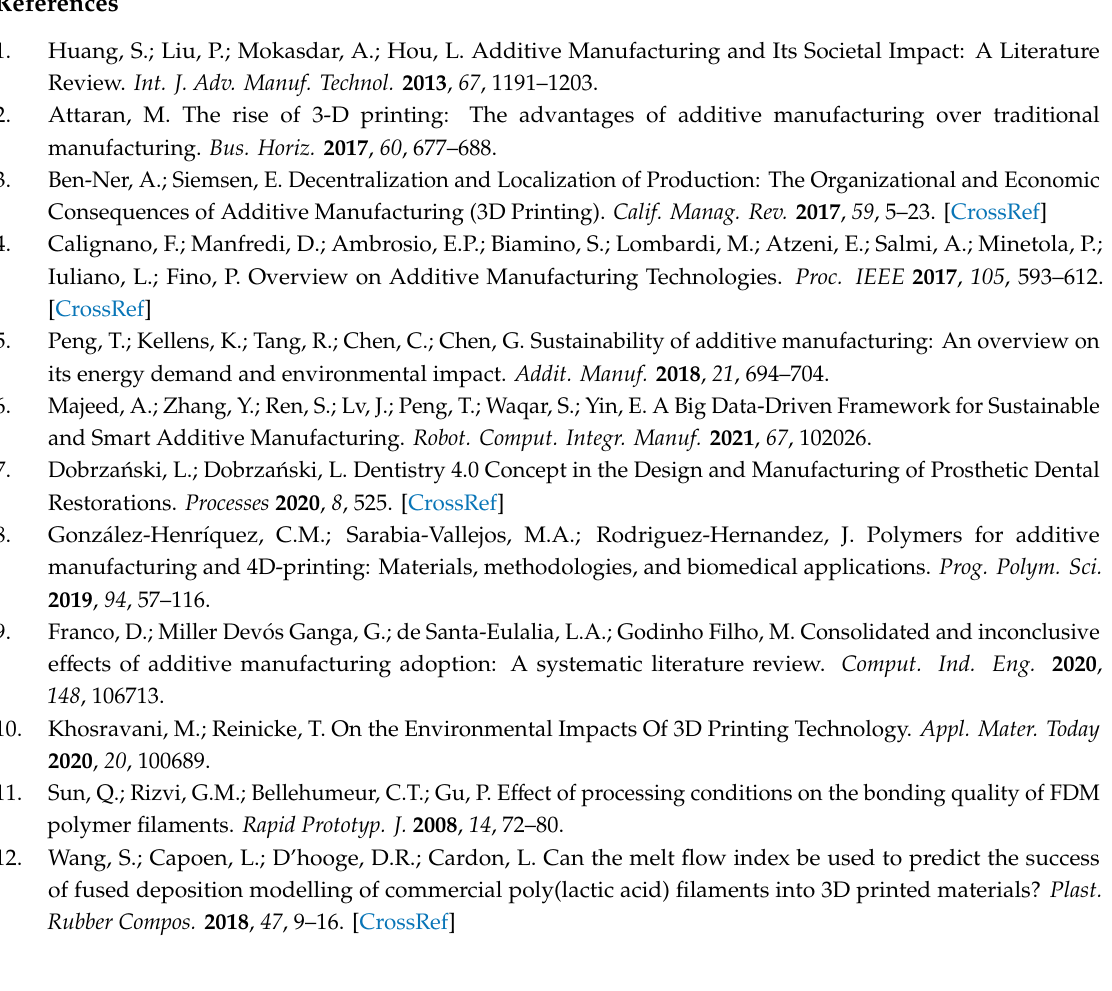
Figure S1: Extra information for Micro-Extruder and Standard Extruder II comparison, Figure S2: Melting e ffi ciency parameter φ for di ff erent compression ratios, Figure S3: Relative velocity for di ff erent values of the pitch angle, Figure S4: Example of di ff erence in the polymer (pellets) to channel volume ratio, Figure S5: Extra information for di ff erent volumetric inlets, Figure S6: Melting profile and Brinkman number for di ff erent values of the channel width, Figure S7: Melting profile and Brinkman number for di ff erent values of the thermal conductivity, Figure S8: Melting profile and Brinkman number for di ff erent values of the power law